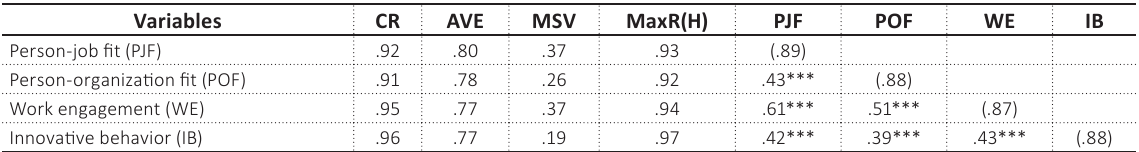
Table 2. Reliability and validity indicators